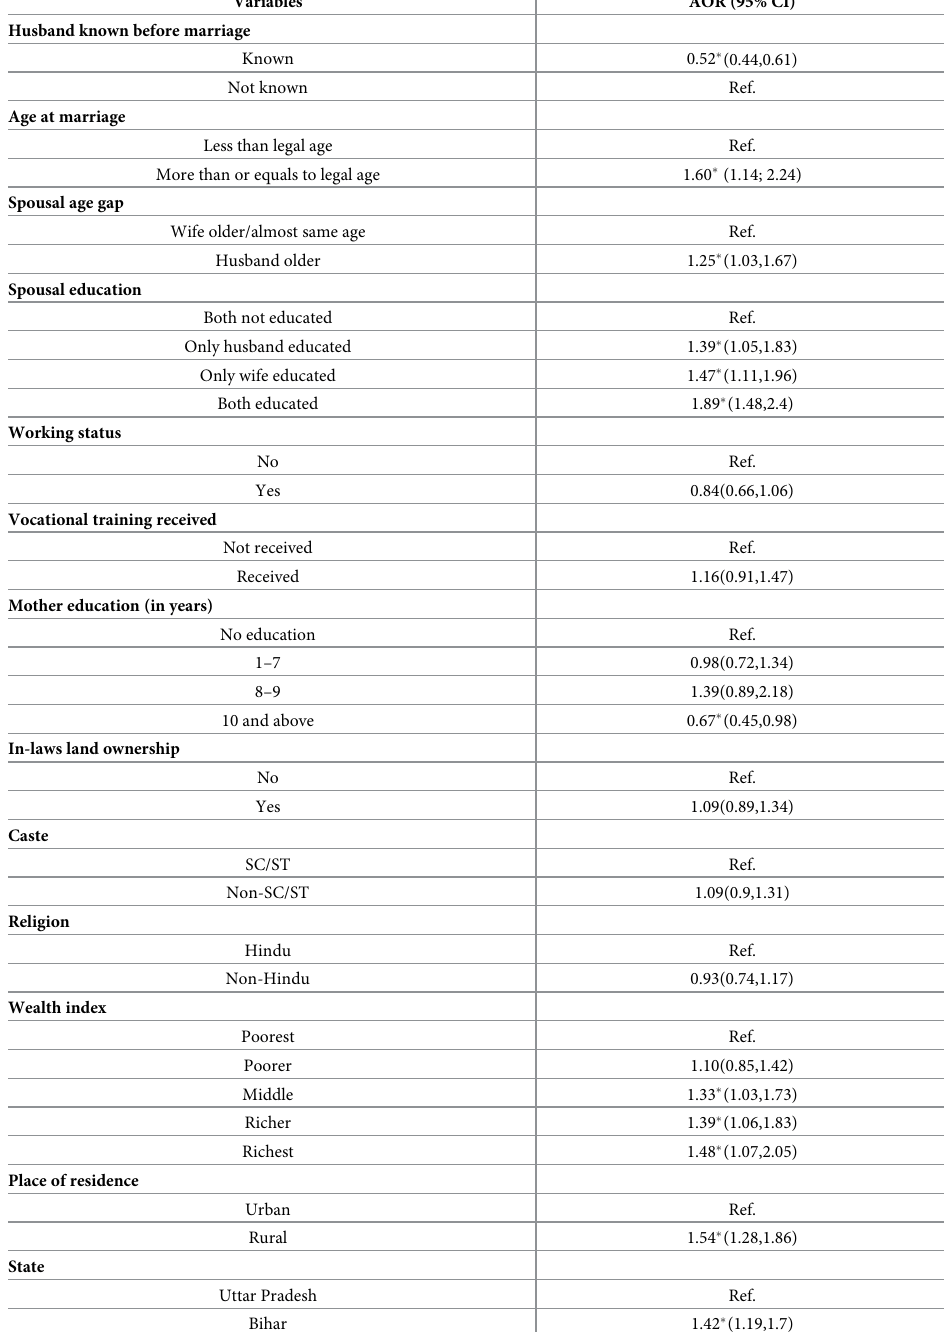
Table 3. Logistic regression estimates for adolescents who paid dowry by background characteristics (15–19